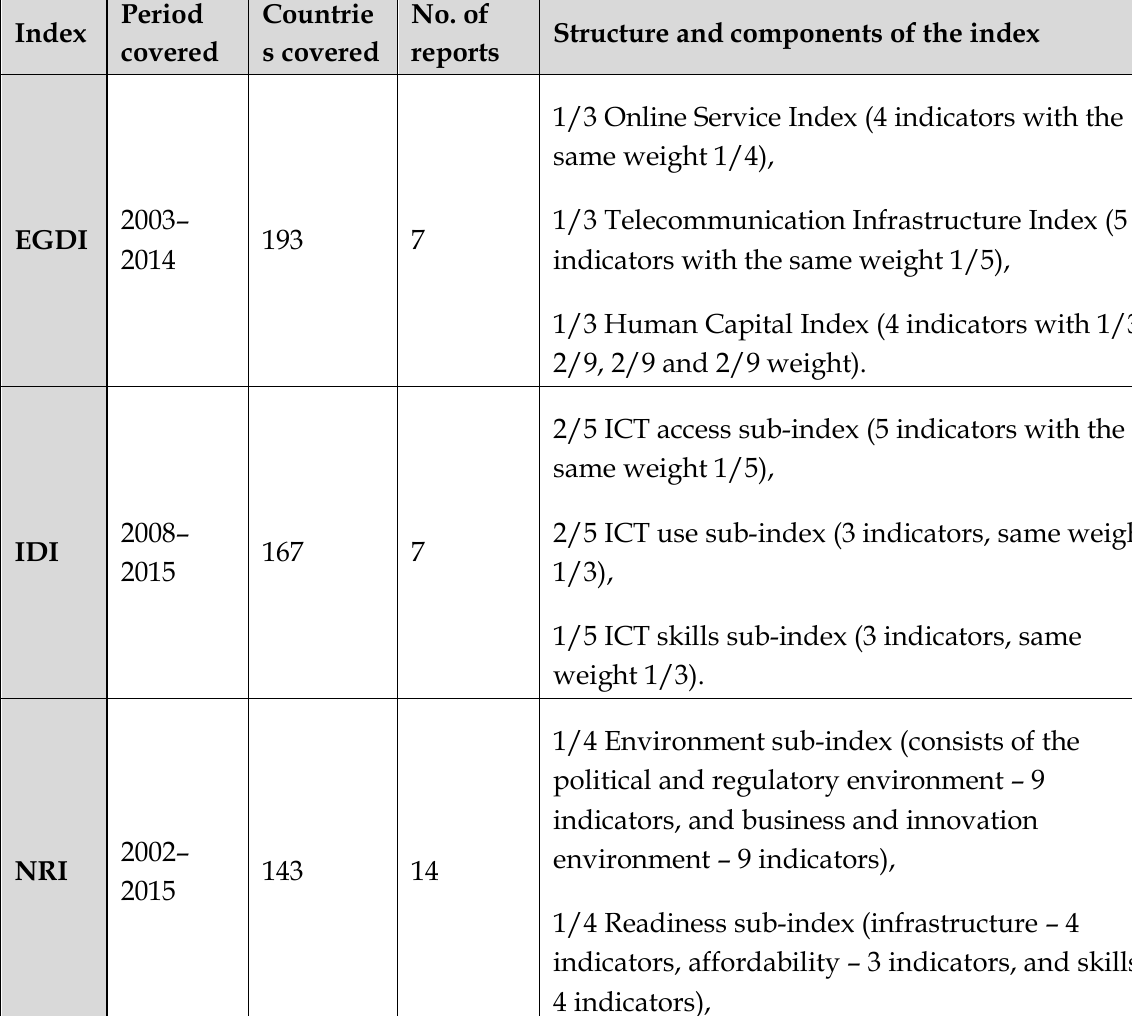
Table 1: Decomposition of the selected indices structure